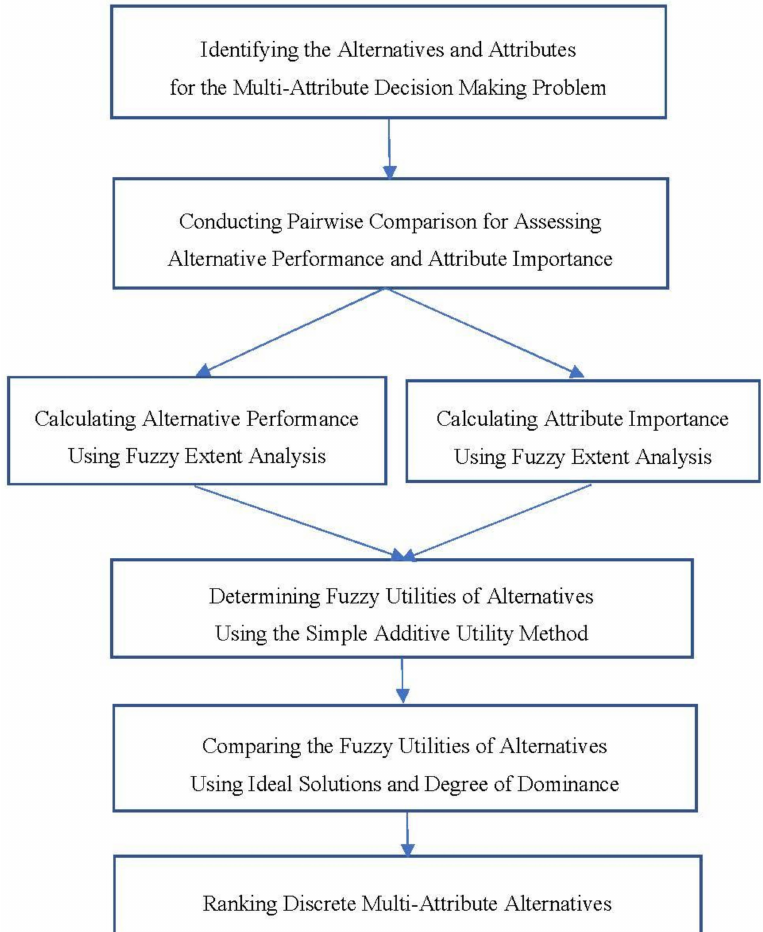
Figure 1. The flow chart for the proposed fuzzy